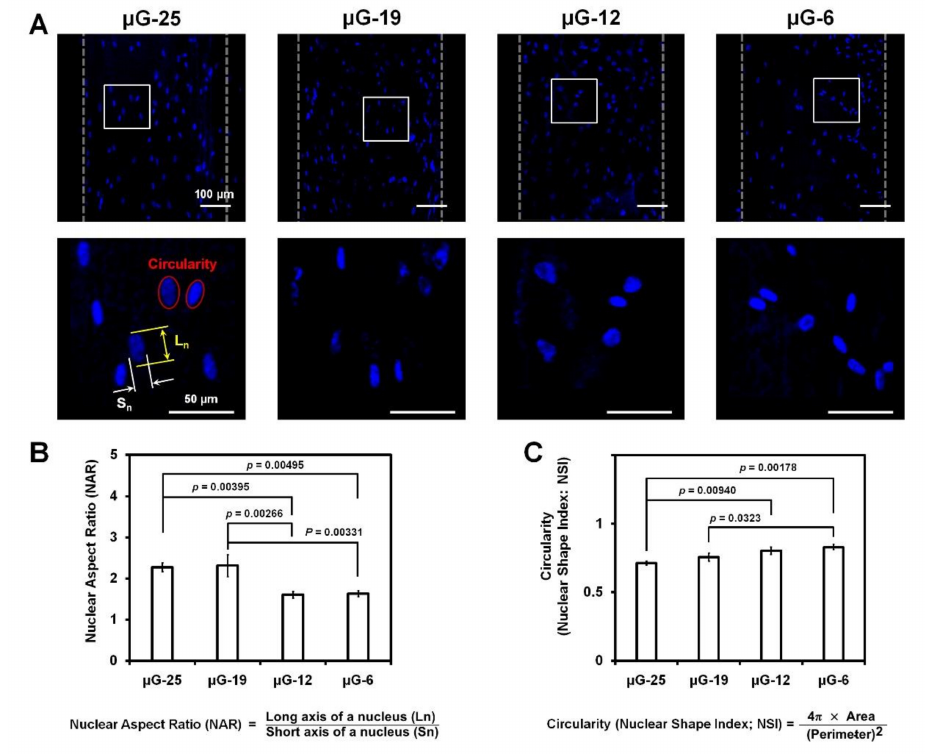
Figure 4. The nuclear aspect ratio (NAR) and circularity (or nuclear shape index; NSI) were measured and calculated to determine the deformation of cell nuclei. ( A ) DAPI-stained cell nuclei showed qualitative correlations of the nuclear deformations with four di ff erent microgroove pattern intervals (25.06 µ m layer thickness for µ G-25, 19.06 µ m for µ G-19, 12.70 µ m for µ G-12, and 6.35 µ m for µ G-6). ( B ) The NAR showed that µ G-25 and µ G-19 had more nuclear elongation than µ G-12 and µ G-6 with quantitative analyses and statistical calculations. ( C ) Circularity (or NSI) values were determined nuclear deformations by the perimeters of nuclei and quantitatively assessed with statistical calculations. Scale bars: 100 µ